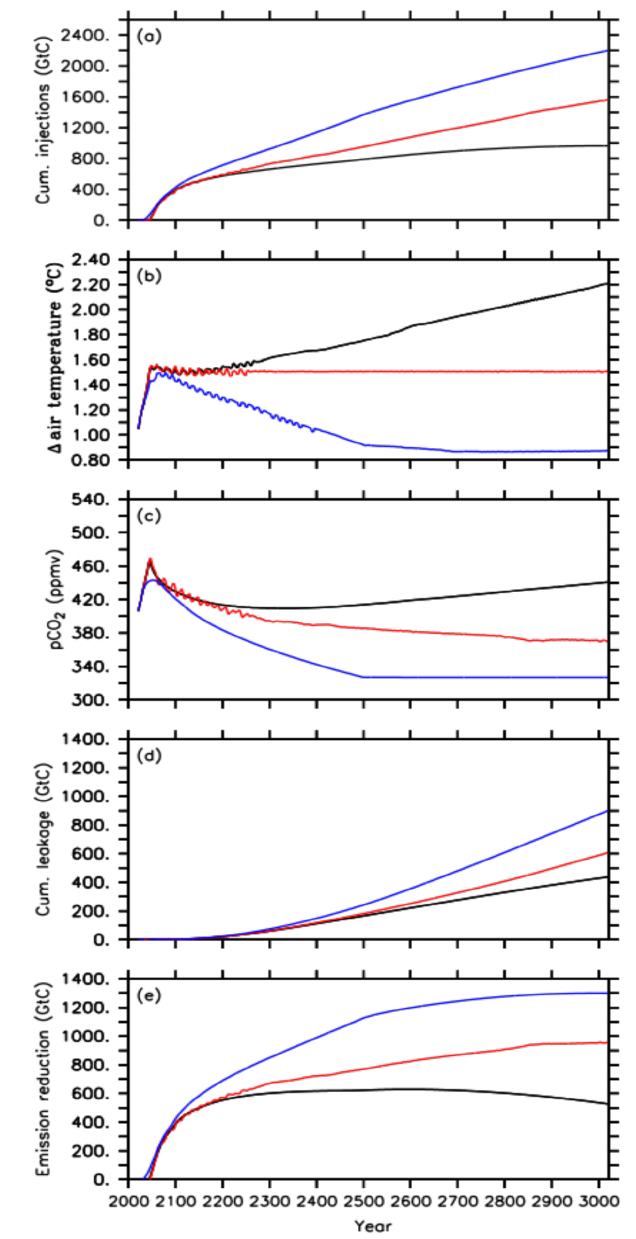
Figure 1. Time series of the different default injection experi- ments, i.e., the A1 simulation (black lines), A2 simulation (red lines) and A3 simulation (blue lines) for (a) cumulative CO 2 in- jections, (b) global mean surface air temperature, relative to prein- dustrial levels, (c) atmospheric CO 2 concentration, (d) cumulative leakage of injected CO 2 and (e) required emission reduction.